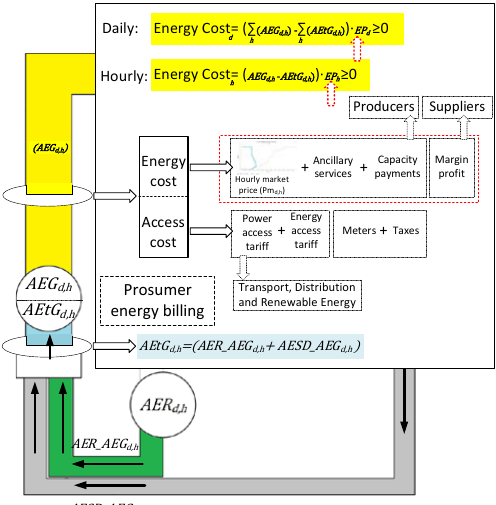
Figure 6. Representation of the prosumer’s billing subjected to the net metering structure. Source: self-elaboration.